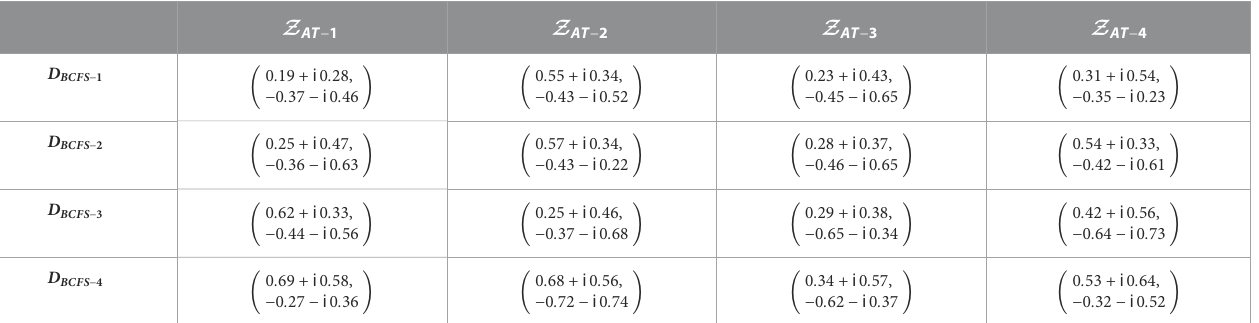
TABLE 3 Data explored by the expert.